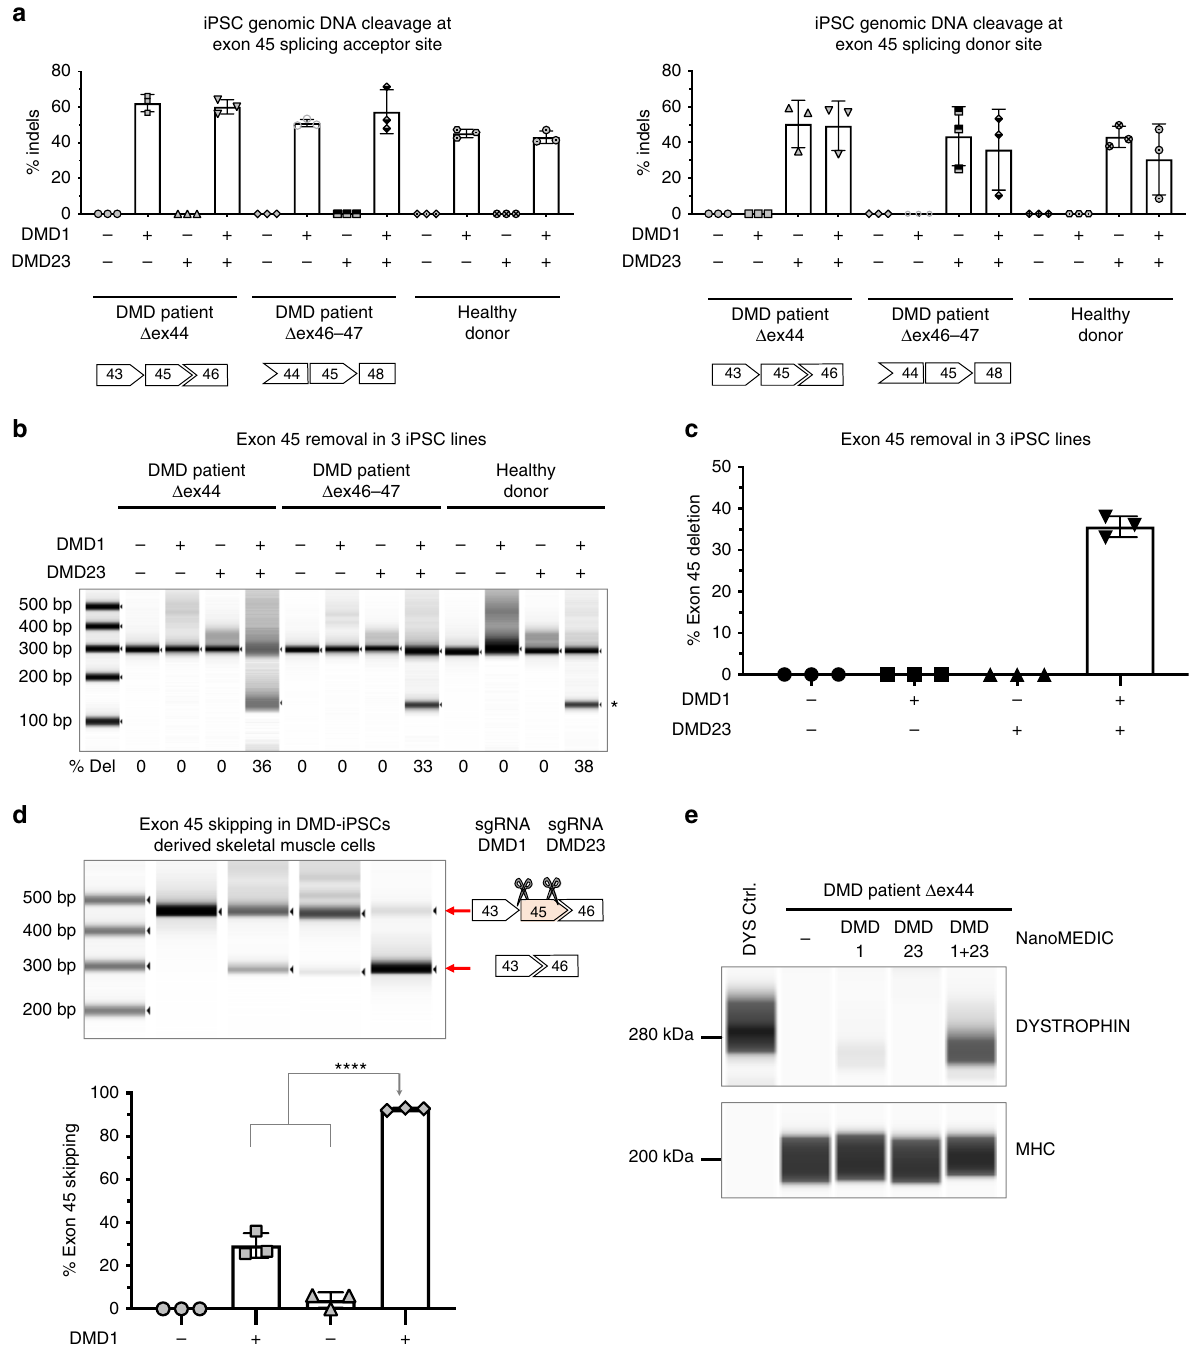
Fig. 4 NanoMEDIC induces highly ef fi cient genome editing in DMD patient iPSCs. a iPSCs of a healthy donor, Δ ex44 DMD iPSCs, and Δ ex46-47 DMD patient iPSCs were inoculated with NanoMEDIC containing RGR-DMD1 (266 ng active RNP complex), RGR-DMD23 (190 ng active RNP complex), or RGR- DMD1 + RGR-DMD23 (266 and 190 ng active RNP complex, respectively). Three days after inoculation, the indel % was analyzed by T7E1 assay. Indel % is depicted at either the SA or SD site of dystrophin exon 45. % Indels: mean ± S.D. from technical triplicates. b Exon 45 removal from gDNA was determined by PCR ampli fi cation. The lower band with the asterisk indicates exon 45 removal by simultaneous cleavage by RGR-DMD1 and RGR-DMD23 NanoMEDIC. c Bar graph representation of average exon 45 removal as from three difference iPSC lines, iPSCs of a healthy donor, Δ ex44 DMD iPSCs, and Δ ex46-47 DMD patients shown in b . Mean ± S.D. from three experiments. % Deletion: mean ± S.D. from three independent cell lines. d DMD patient-derived Δ ex44 iPSCs, treated with RGR-DMD1, RGR-DMD23 or RGR-DMD1 + RGR-DMD23 NanoMEDIC, were differentiated into skeletal muscle cells. PCR ampli fi cation of exons 43 to 46 from extracted cDNA was performed. The lower band indicates exon 45 skipping. Mean ± S.D. from technical triplicates. ****, P < 0.0001 by one-way ANOVA. e Dystrophin protein expression was also analyzed by ProteinSimple Wes and compared with HEK293T cells overexpressing dystrophin cDNA. Myosin heavy chain protein was also analyzed as a loading control. Results are representative of two independent Protein Wes runs from a single experiment. Source data are provided as a Source Data fi